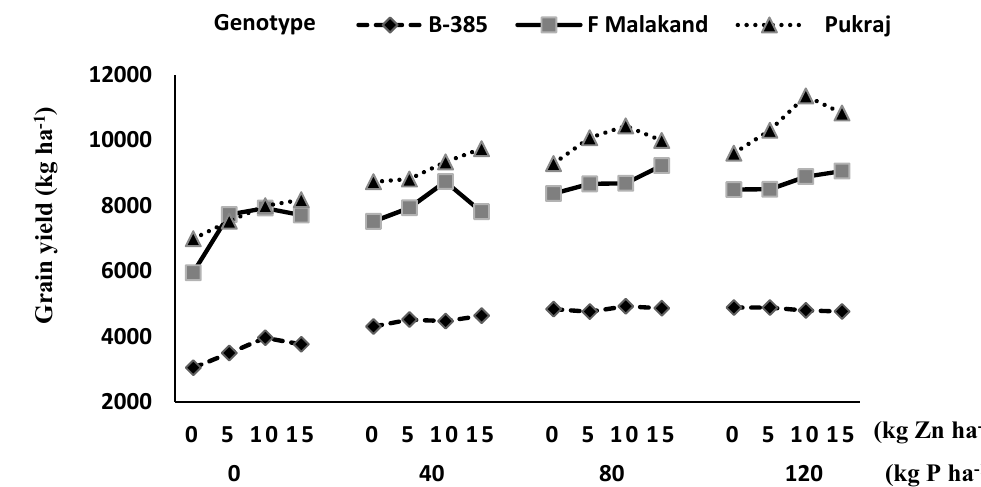
Figure 3. Grain yield (kg ha − 1 ) of rice as affected by phosphorus into zinc into genotype (P × Zn × G) interaction.